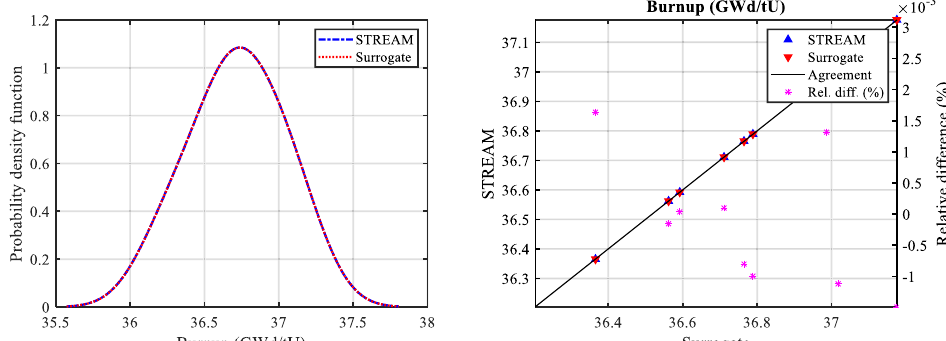
Figure 4. Comparison of burnup and it’s PDFs at discharge from 10 runs.